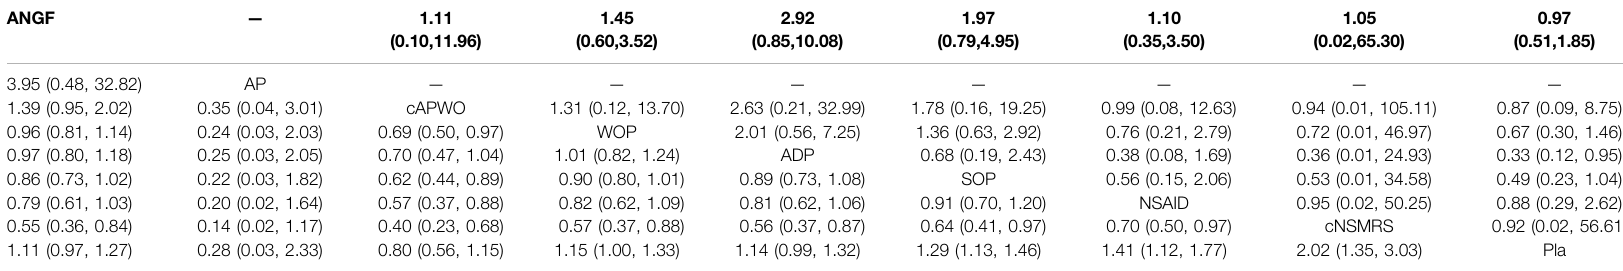
TABLE 3 | The league plots of main safety analysis. TEAEs (Red) and SAEs (Blue). (From the top left to the bottom right, higher comparator vs lower comparator, RR with 95% CI.) ANGF —